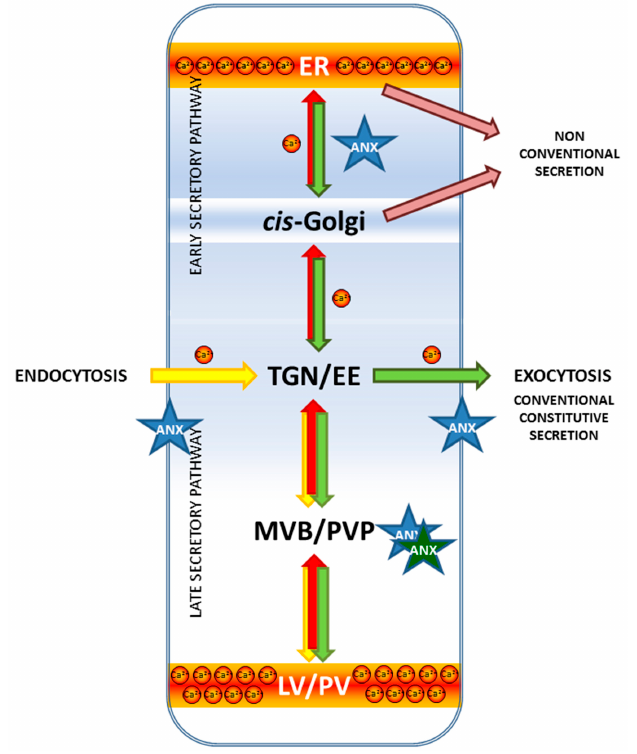
Figure 3. Potential targets for annexin participation in intracellular transport in plant cells. There is evidence that annexins participate in both the early and late secretory pathways including endo- and exocytosis. Annexins are also suggested to function in conventional constitutive secretion as well as non-conventional secretion; green arrow—forward route, red arrow—reverse route; yellow arrow—endocytic route.